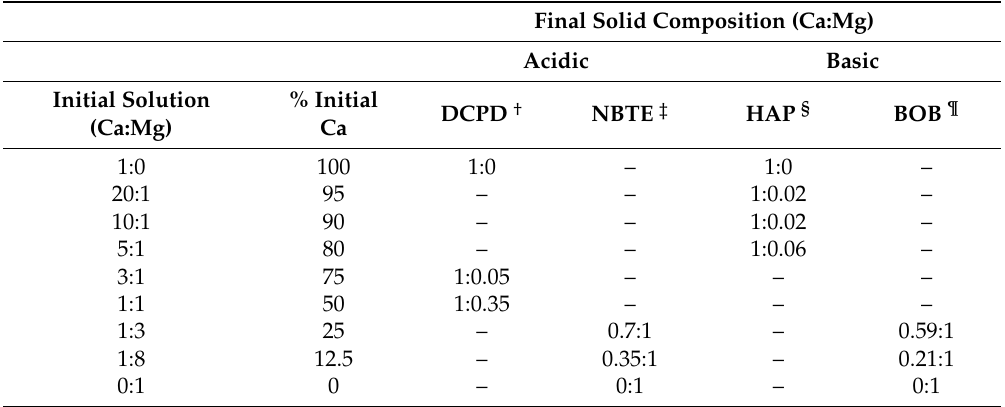
Table 1. Elemental composition of synthesized minerals exhibiting proportions of Mg / Ca substitution. Final Solid Composition (Ca:Mg) Acidic